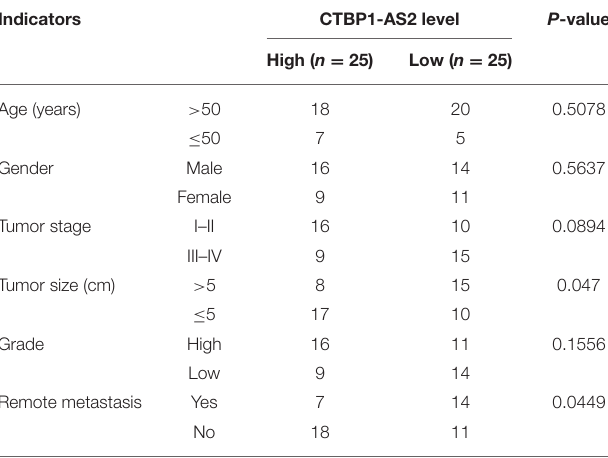
TABLE 1 | Relationship between CTBP1-AS2 level and clinical characteristics in colorectal